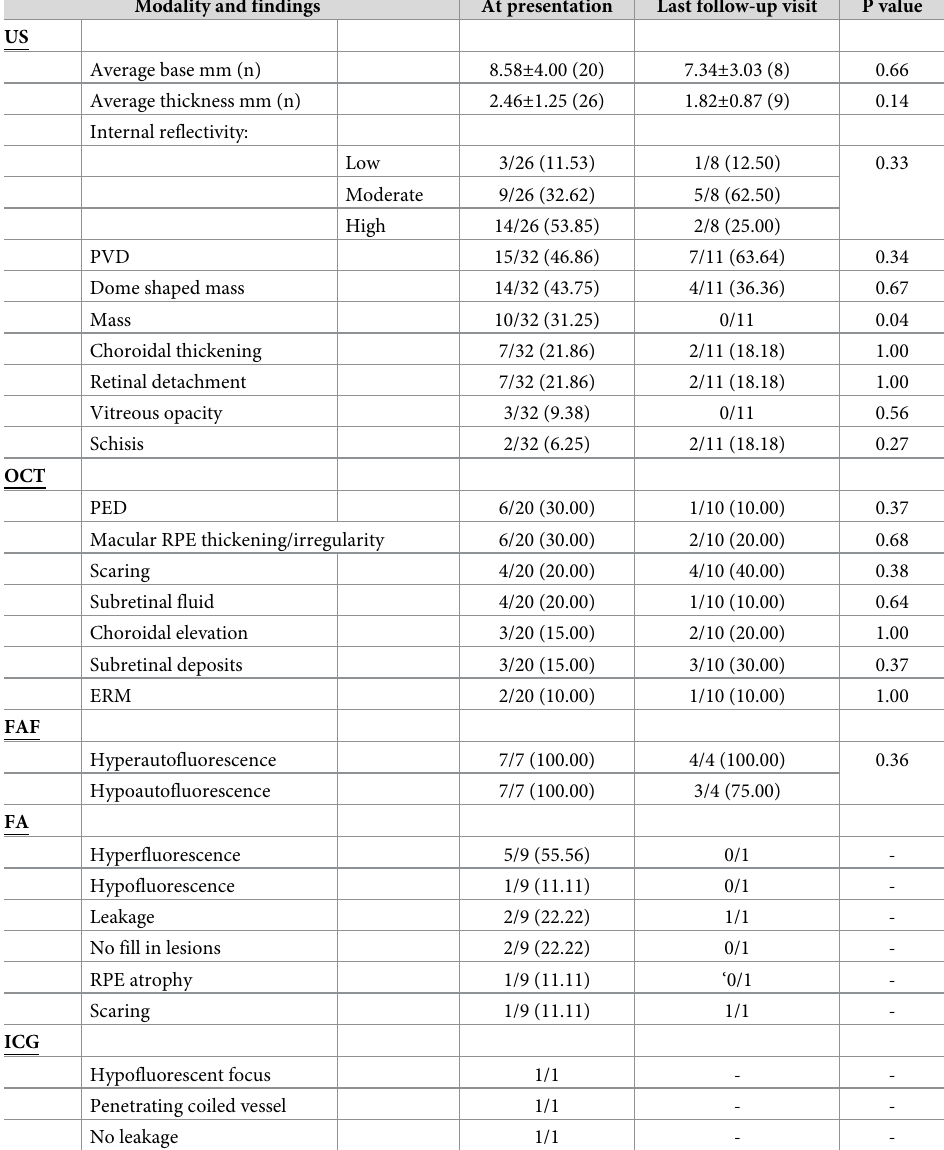
Table 4. Main imaging findings. Modality and